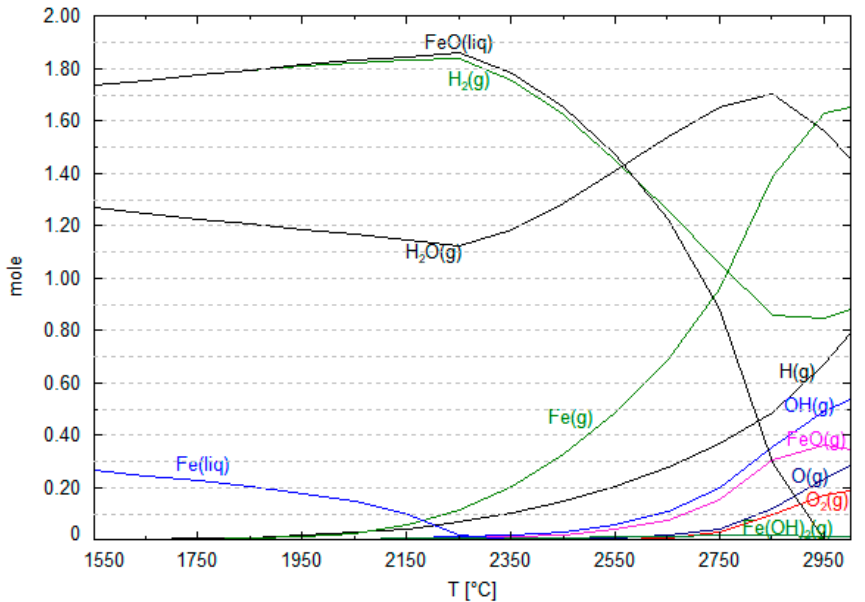
Figure 9. Equilibrium of 3 mol of hydrogen and 1 mol of Fe 2 O 3 with a total pressure of 1 atm assessed by FactSage™ 7.1 (Database FactPS 2017).